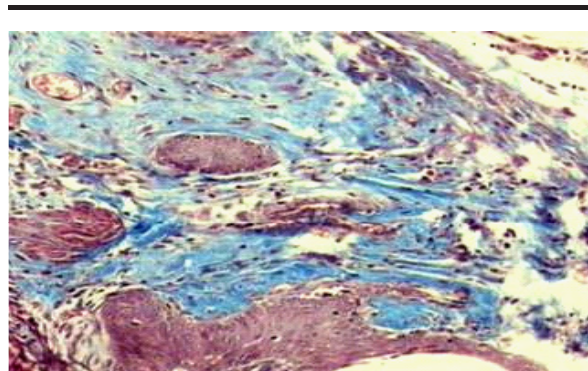
FIGURA 10 - Animais dos dois subgrupos, em relação à fibrose da cicatriz (colagenização) no 3º dia